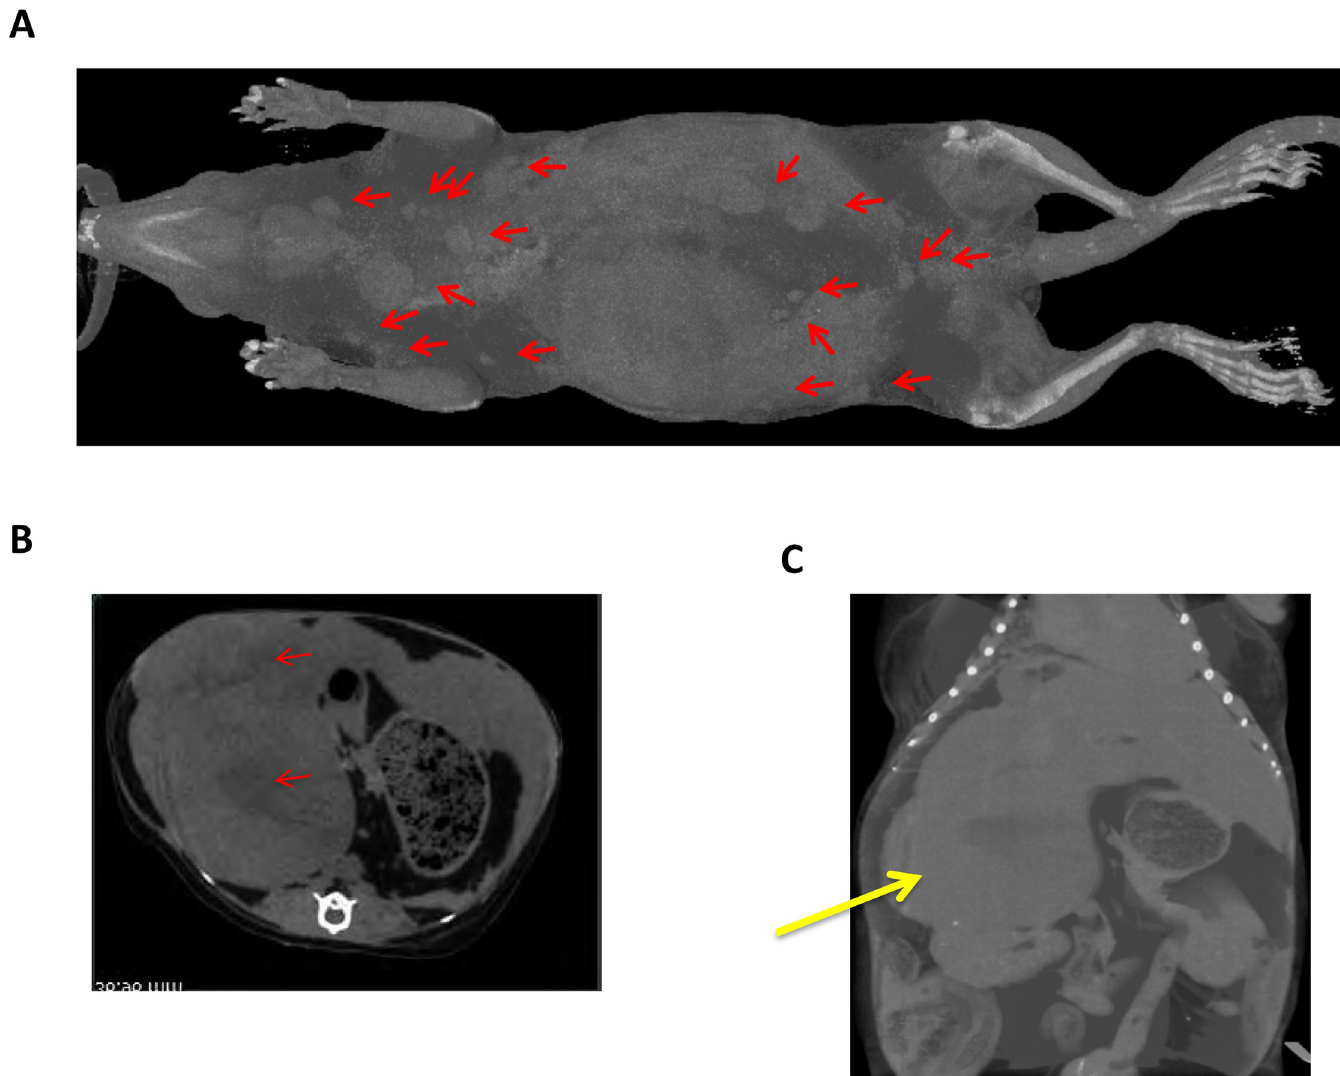
Fig 7. X-ray CT (LCT-200) analysis of a tumor-bearing tree shrew (No.26, 4 years 11 months old). ( A ) Three-dimensional (3D) analysis of whole tree shrew body. Position of sarcoma was indicated by red arrows. ( B ) 3D tomogram of tree shrew. Arrows indicating tumor tissues. ( C ) 3D analysis of tree shrew belly. Yellow arrows indicate the large intraperitoneal